Question: What style of plot is this figure drawn as?
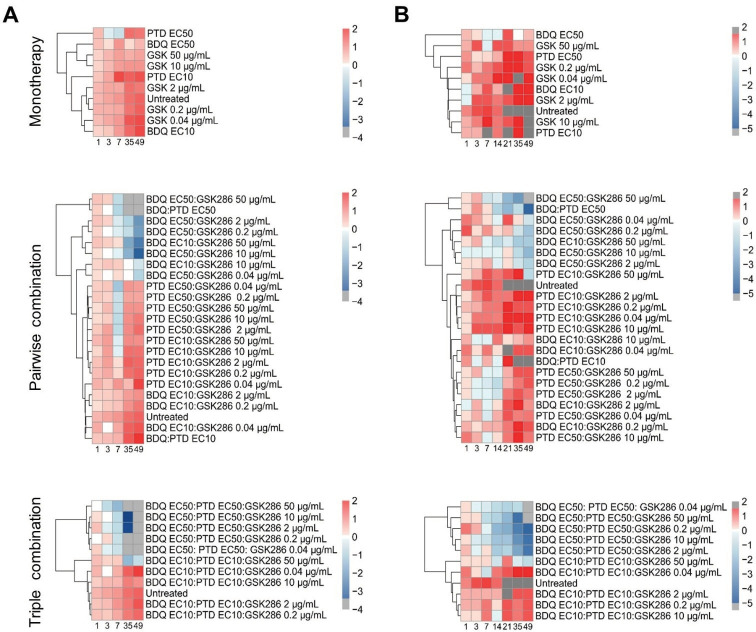
Answer: heatmap